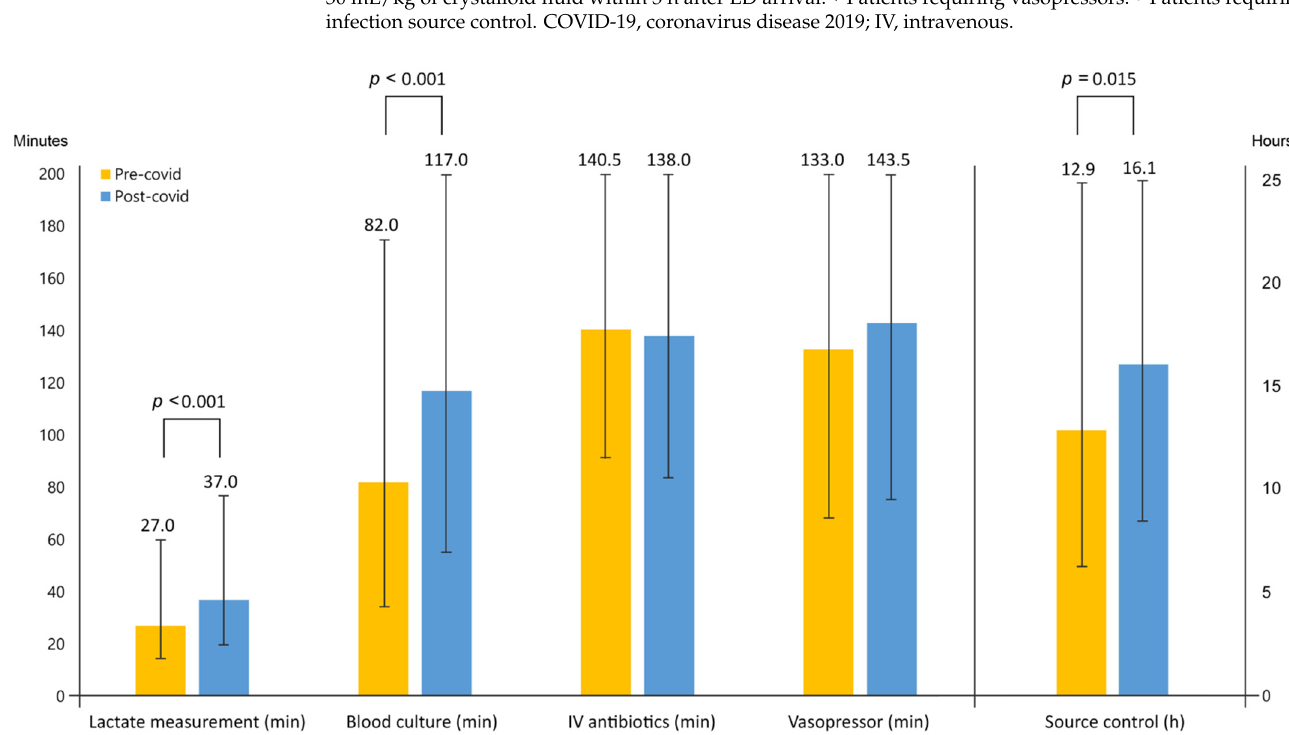
Figure 2. Propensity-matched cohort analysis of time interval from triage to sepsis shock-related intervention. The median time to lactate measurement in the pre-COVID-19 group and post- COVID-19 group was 27.0 min [IQR 14.0–60.0] and 37.0 min [IQR 20.0–77.0] ( p < 0.05). The median time to blood culture in the pre-COVID-19 group and post-COVID-19 groups was 82.0 min [IQR 34.0–175.0] and 117.0 min [IQR 55.0–205.0] ( p < 0.05). The median time to IV antibiotics in the pre- COVID-19 group and post-COVID-19 groups was 140.5 min [IQR 91.0–222.0] and 138.0 min [IQR 84.0–213.0] ( p = 0.19). The median time to vasopressor in the pre-COVID-19 group and post-COVID- 19 groups was 133.0 min [IQR 68.0–240.0] and 143.5 min [IQR 75.0–253.0] ( p = 0.09). The median time to source control in the pre-COVID-19 group and post-COVID-19 groups was 12.9 h [IQR 6.3–27.4] and 16.1 h [IQR 8.6–49.1] ( p = 0.01). COVID-19, coronavirus disease 2019; IV, intravenous. 3.4. Variables Associated with in-Hospital Mortality The COVID-19 period was not found to be associated with in-hospital mortality in the univariable logistic regression analysis (OR, 1.14 [95% CI, 0.97–1.34], p = 0.11; Table 4). In the multivariable logistic regression analyses, the COVID-19 period was not associated with in-hospital mortality (aOR, 1.00 [95% CI, 0.84–1.20], p = 0.98). Initial lactate levels (aOR, 1.13 [95% CI, 1.10–1.16], p < 0.001), SOFA score (aOR, 1.18 [95% CI, 1.16–1.22], p < 0.001), and Sepsis-3-defined septic shock (aOR, 1.63 [95% CI, 1.30–2.04], p < 0.001) were associated with in-hospital mortality. Delayed antibiotic administration ( ≥ 3 h) was signif- icantly associated with an increase in in-hospital mortality, compared to antibiotic admin- istration within three hours. Table 4. Univariable and multivariable logistic regression analysis of in-hospital mortality. Univariable